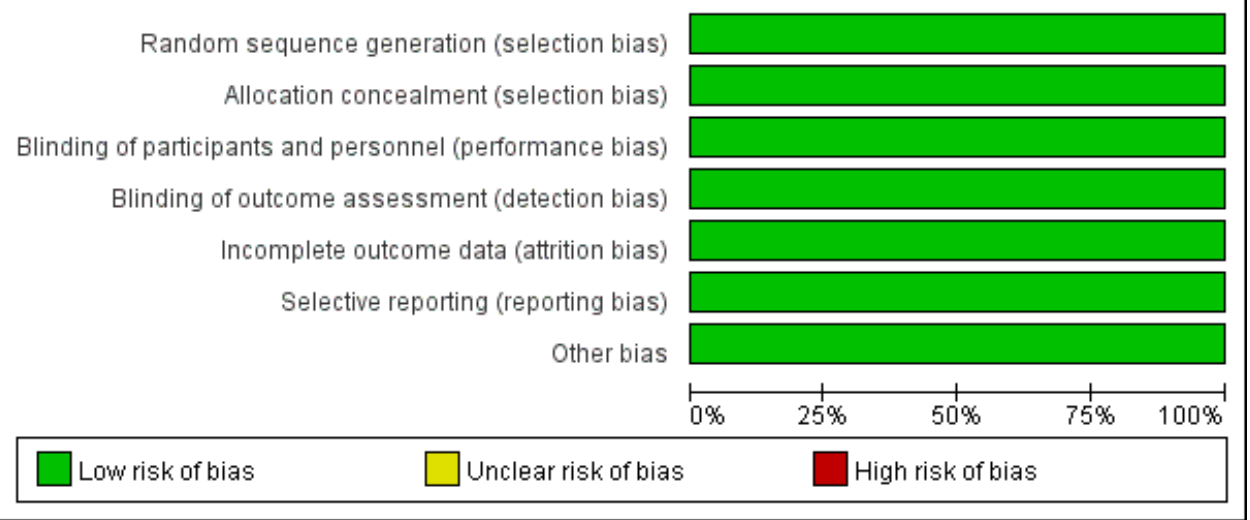
Figure 2. Summary of each RCT appraised by Revman 5.3.